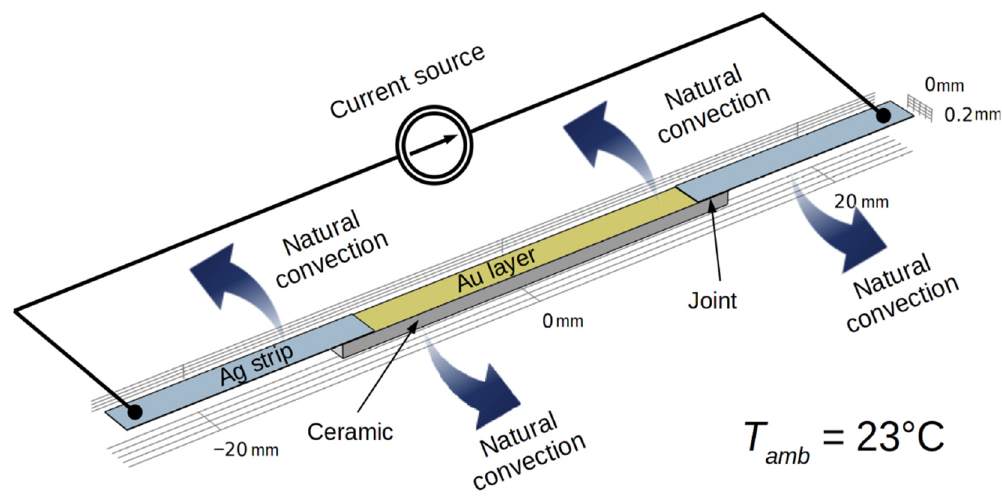
Figure 6. Geometry and boundary conditions of the numerical model of the sample.